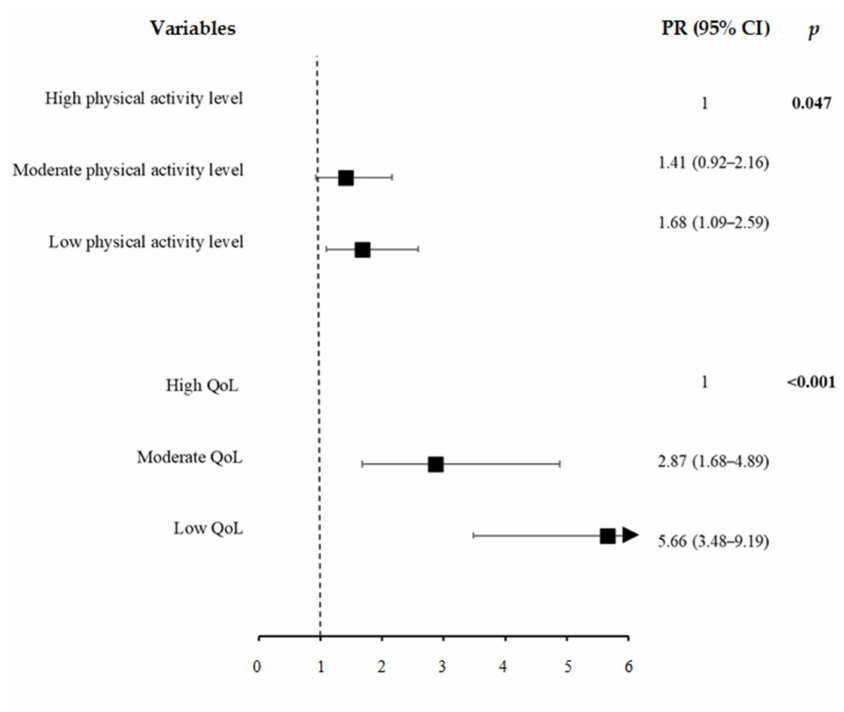
Figure 4. Poisson regression results for depressive symptoms and variables related to physical activity level and QoL ( n =